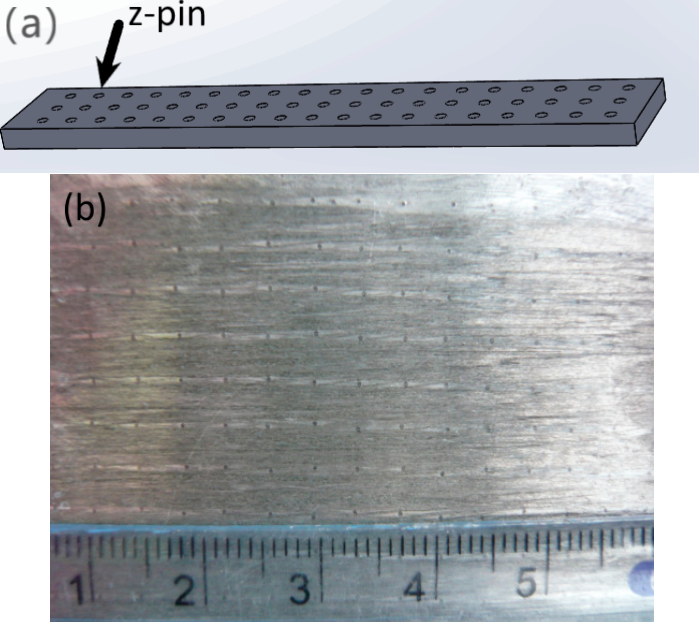
Figure 2. The ( a ) scheme and ( b ) photo of the z-pinned composite structure. Table 4. The z-pin spacing of several types of z-pinned Cf/Al composite samples. Z-pin volume content (%)